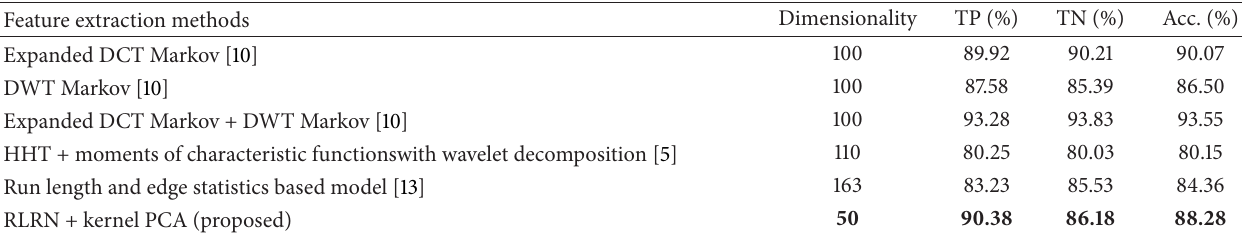
Table 4: Comparison between proposed approaches and other methods.